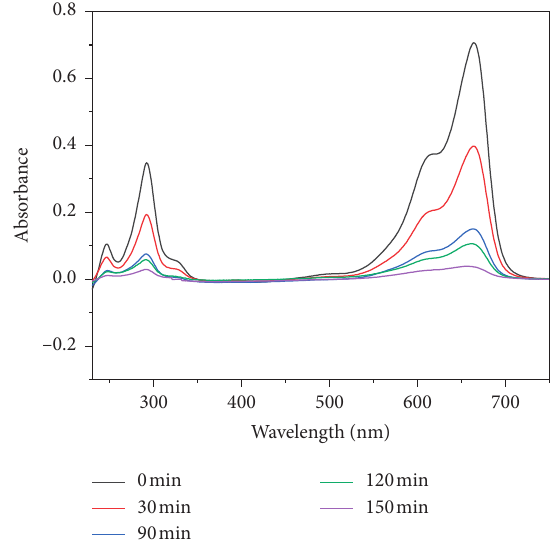
Figure 8: UV-Vis spectral changes with reaction time ([MB] � 50mg/L, [H 2 O 2 ] � 14.68 mM, natural pH, and [composite] � 2.5